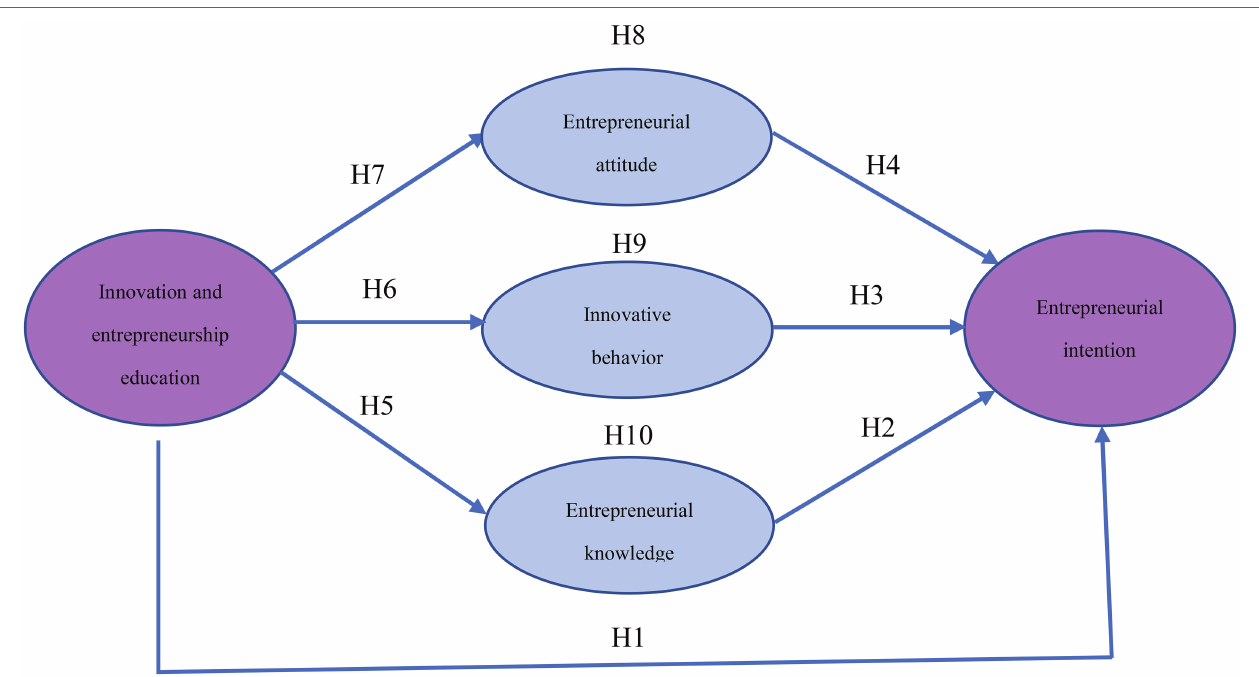
FIGURE 2 | The mechanism model of entrepreneurial education.